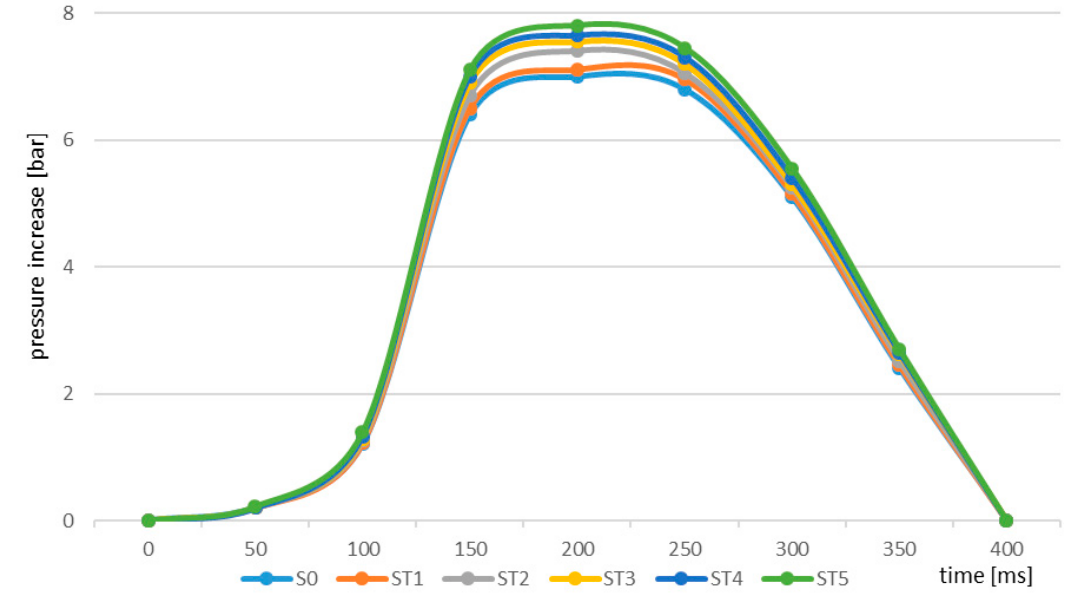
Figure 3. Explosion pressure curve identified for samples of raw and torrefied wheat straw.